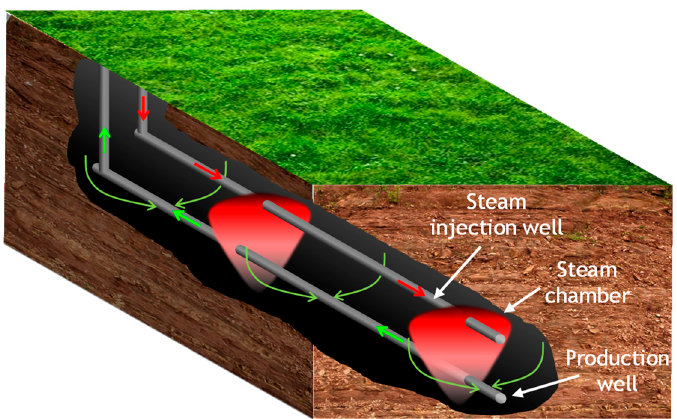
Figure 1. Steam assisted gravity drainage. A horizontal well injects steam into the reservoir and the heat transfer from the steam to the rock and fluids reduces the viscosity of the oil, which flows by the effect of gravity towards a producer well at the bottom of the reservoir.